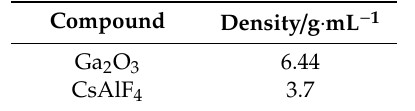
Table 2. Density of the